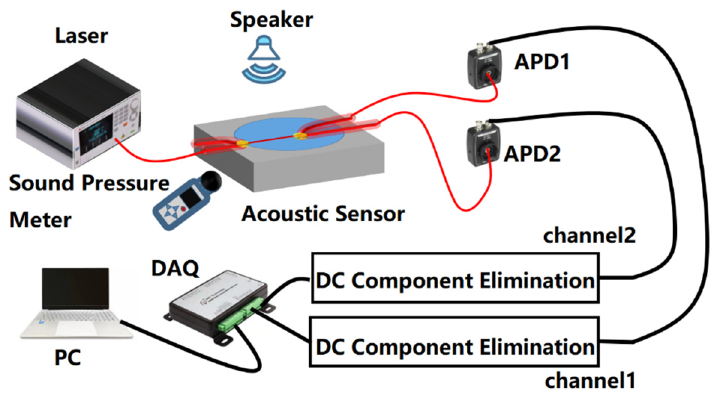
Figure 7. Schematic diagram of the acoustic wave measurement system.